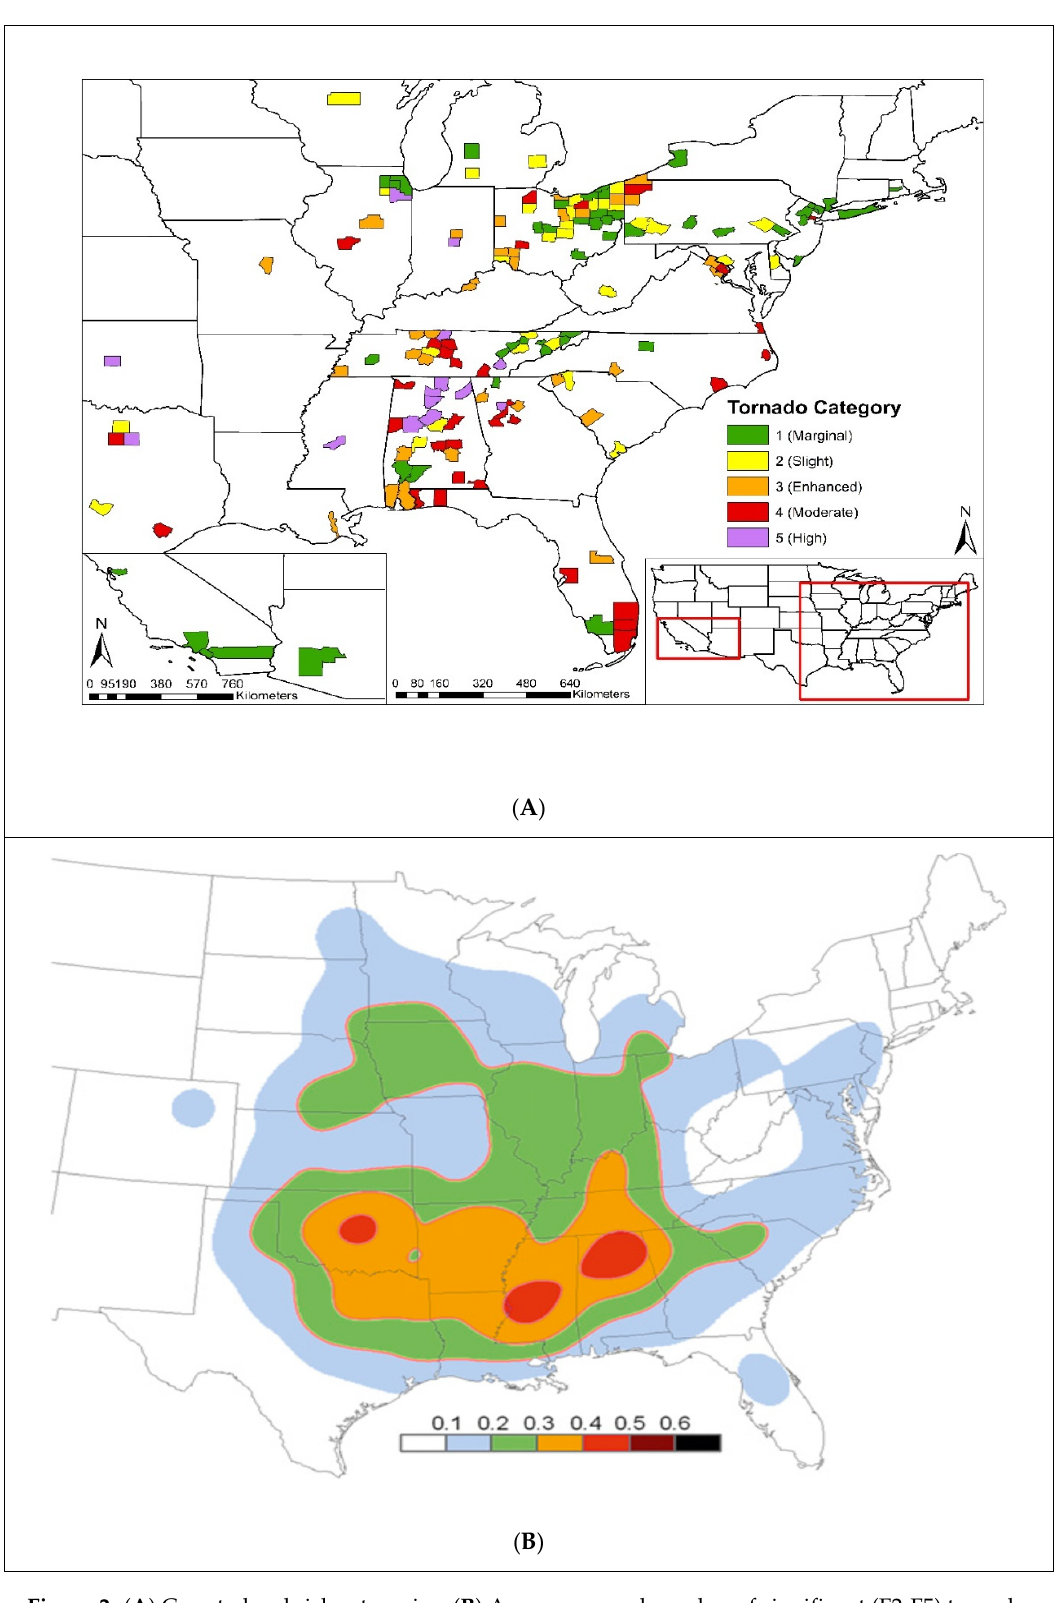
Figure 2. ( A ) County level risk categories. ( B ) Average annual number of significant (F2-F5) tornado initiation-locations within 40 km (25 mi) of a point for the 1973–2011 period, adopted from Ref. [39] © American Meteorological Society. Used with permission.